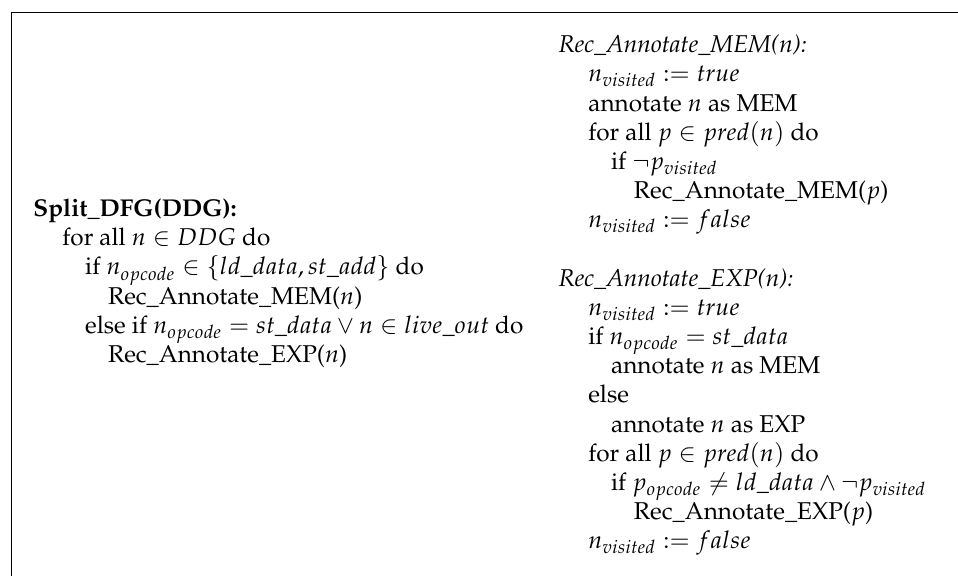
Figure 4. DDG Splitting Algorithm Split_DFG .